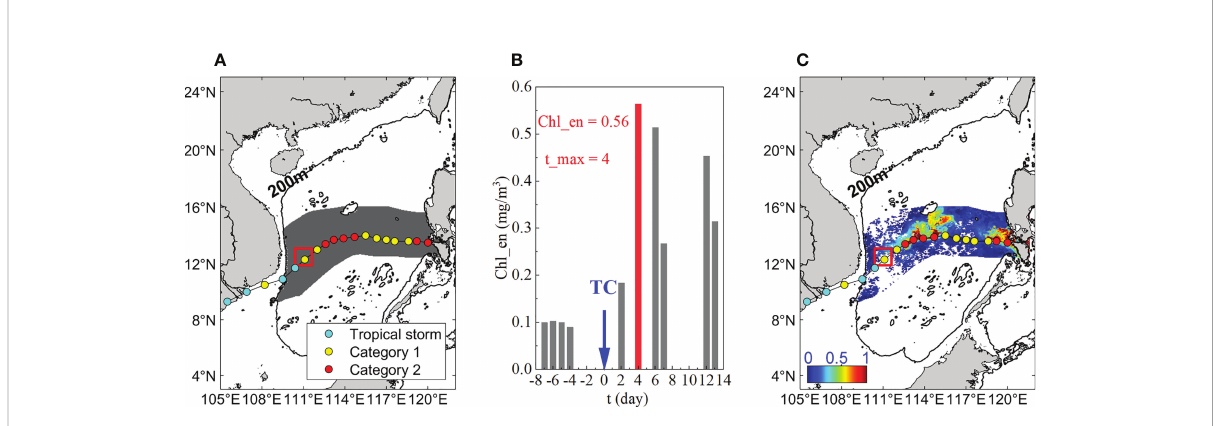
(C) composite Chl_en plot.